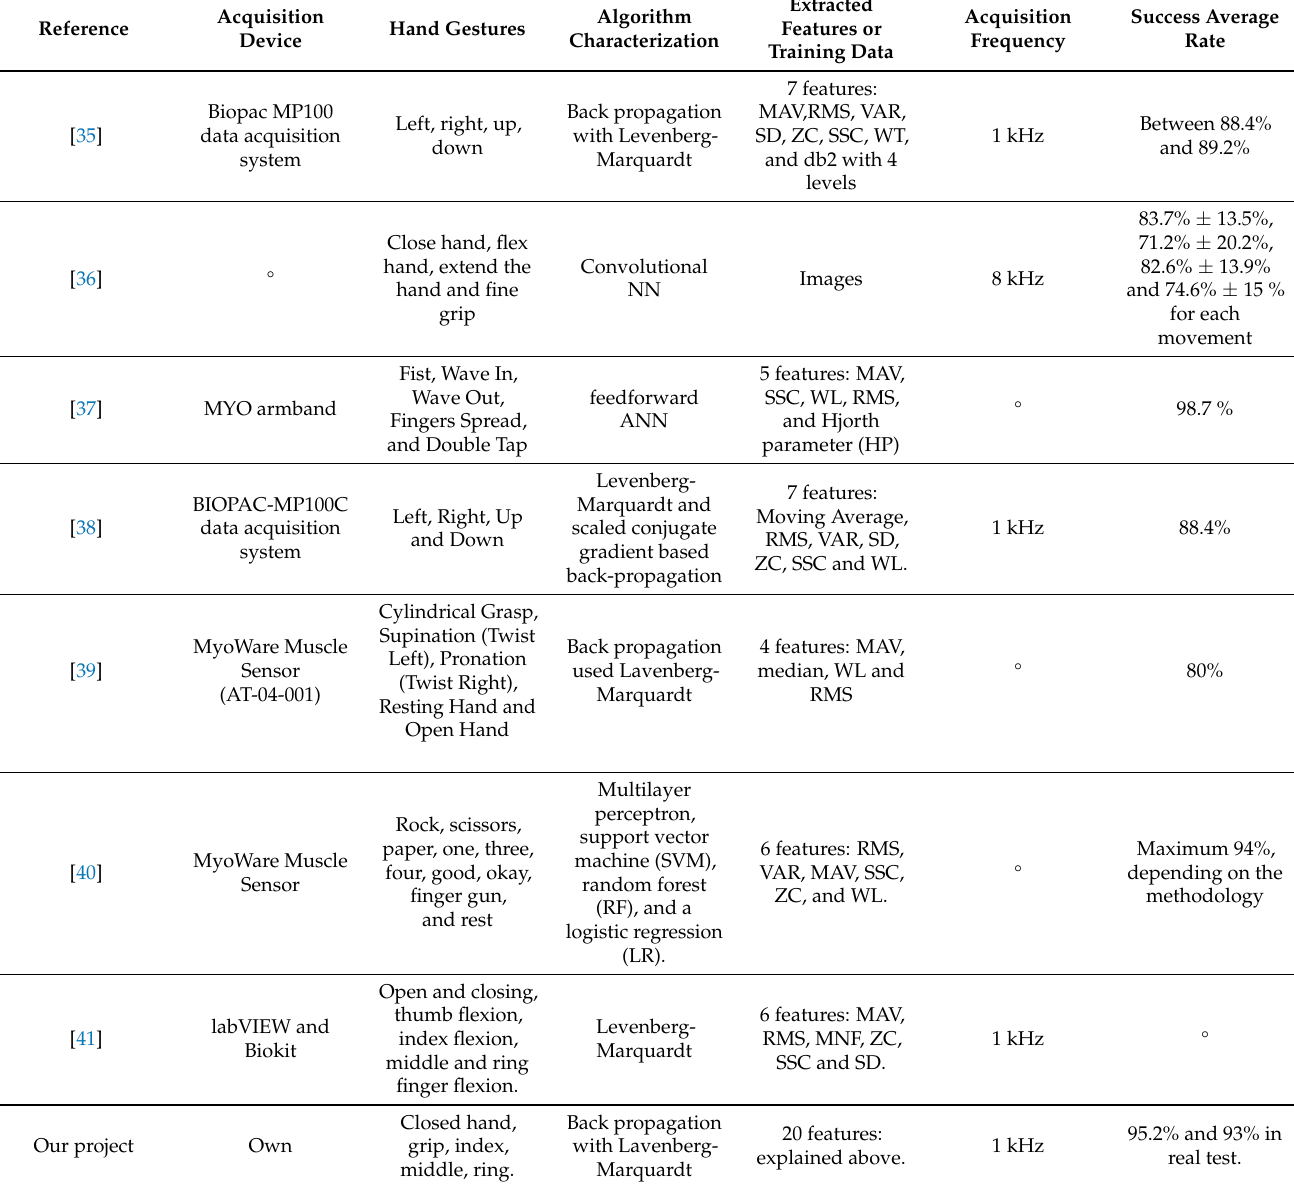
Table 3. Comparison of acquisition